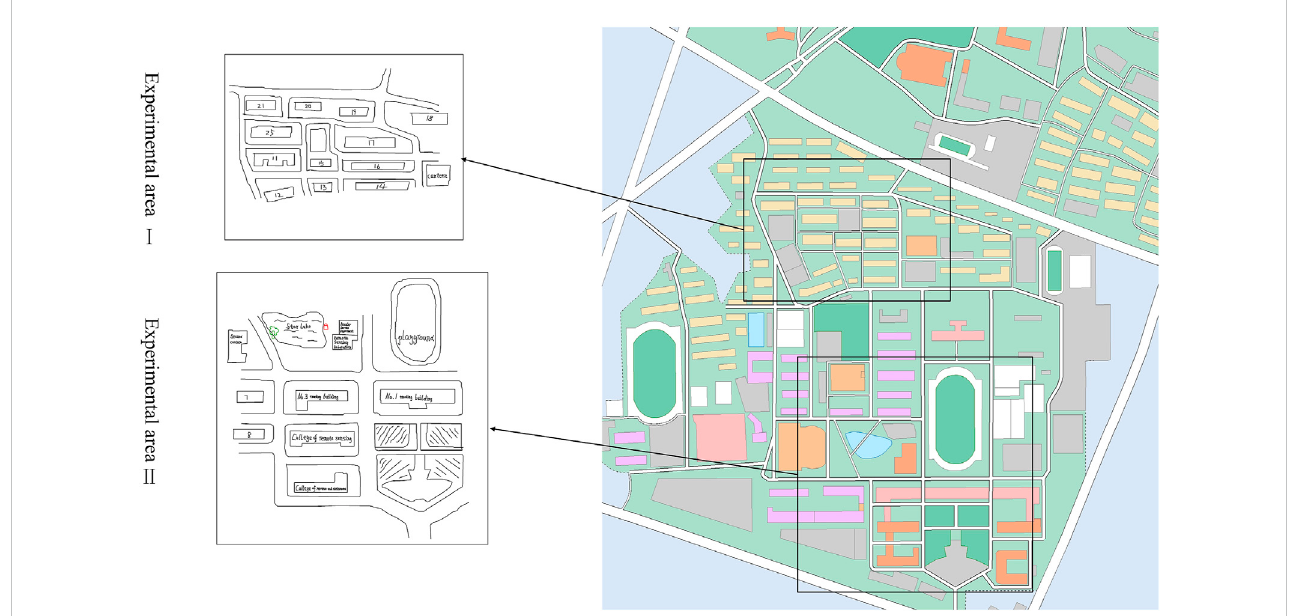
FIGURE 8 The range of sketch and vector maps.